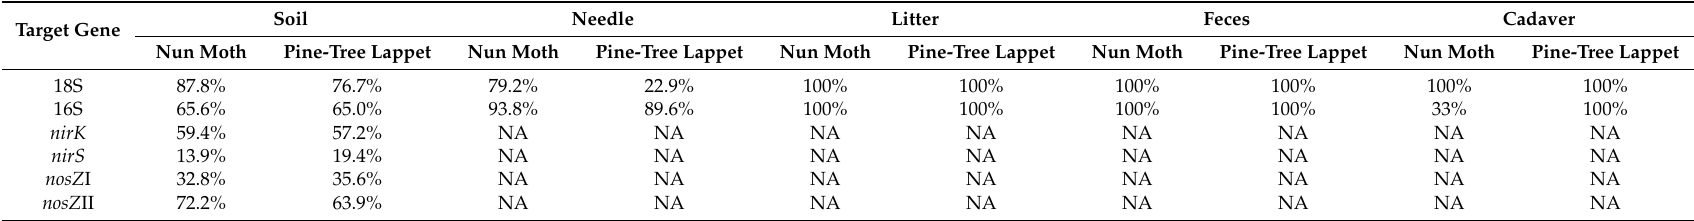
Table A4. Detectable target genes in % of all samples during the outbreak of the nun moth ( Lymantria monacha L.) and pine tree lappet ( Dendrolimus pini L.). Target